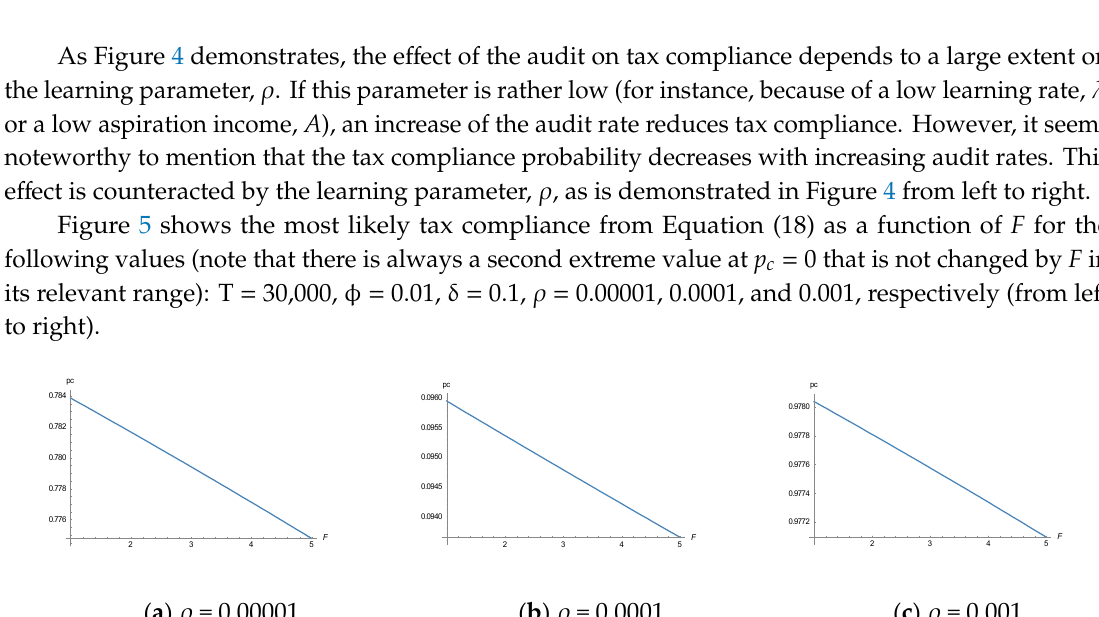
Figure 4. Tax compliance probability, p c , as a function of ϕ for different values of ρ : ( a ) ρ = 0.00001, ( b ) ρ = 0.0001 and ( c ) ρ = 0.001 .